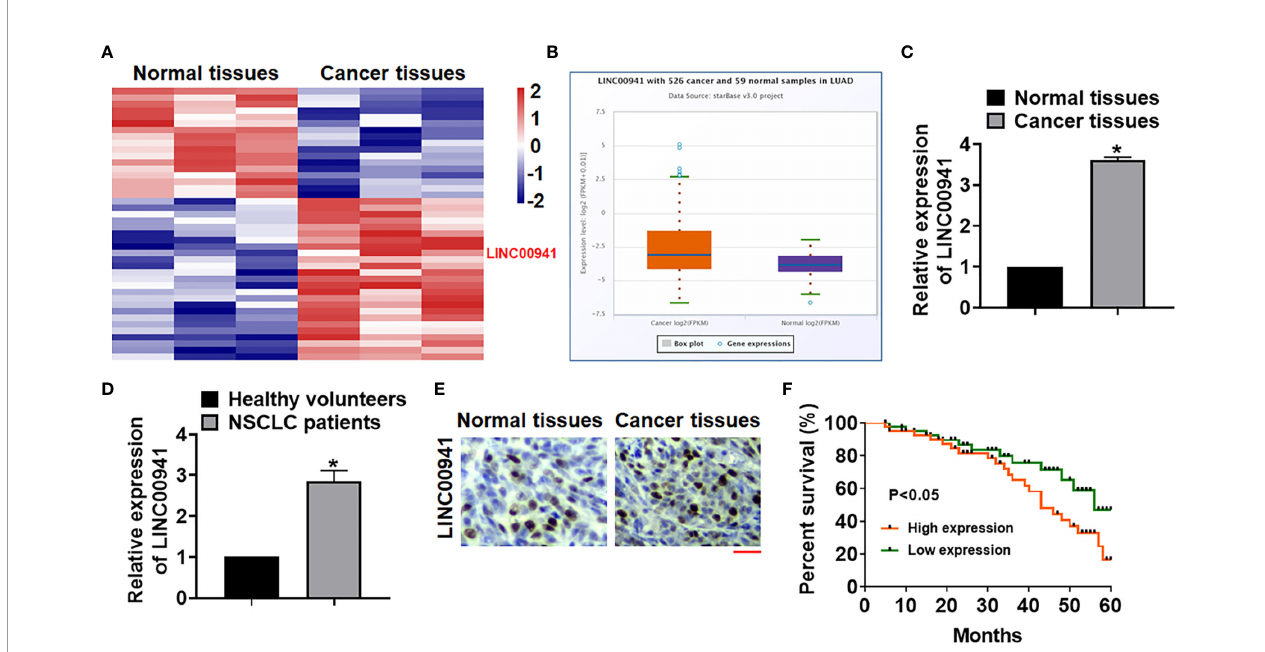
FIGURE 1 | The expression of LINC00941 in NSCLC tissues. (A) LncRNA expression pro fi les in normal and cancer tissues of NSCLC patients. (B) ENCORI website showed LINC00941 level in cancer and normal samples of lung adenocarcinoma (LUAD). (C) The expression of LINC00941 in normal and cancer tissues was detected by qRT-PCR. (D) RNA in plasma of healthy volunteers and NSCLC patients was isolated, and LINC00941 expression was calculated. (E) ISH analysis for LINC00941 expression normal and cancer tissues of NSCLC patients. Scale bar, 200 m m. (F) 5-years ’ survival rate of NSCLC patients with high and low expression of LINC00941. Data are mean ± SD; *P < 0.05. All experiments were repeated three